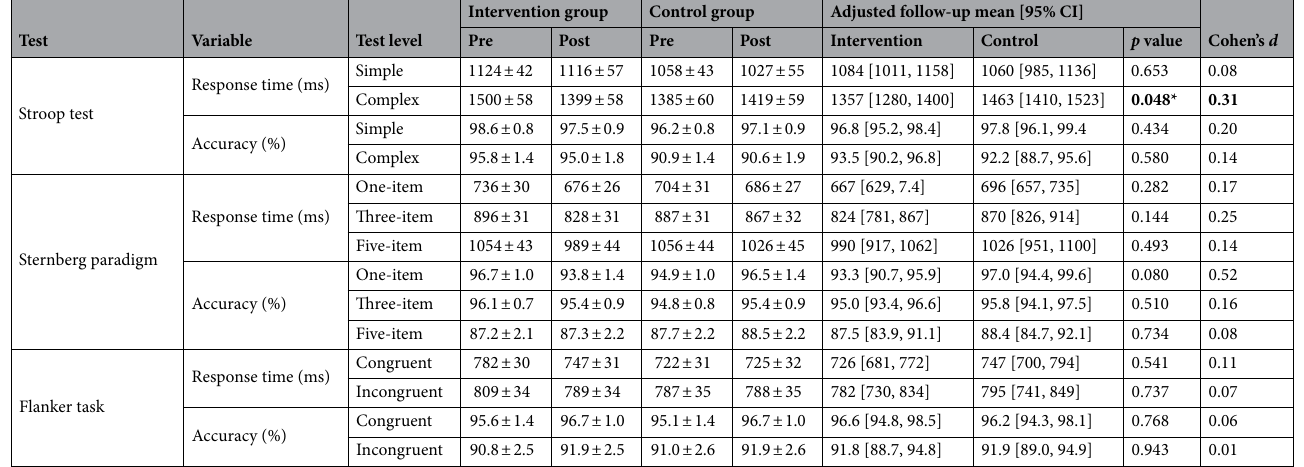
Table 1. Cognitive function data for the intervention and control groups at baseline and follow-up. Data are mean ± SEM. Significant values are in bold. *Significant difference between intervention and control group at follow up ( p <